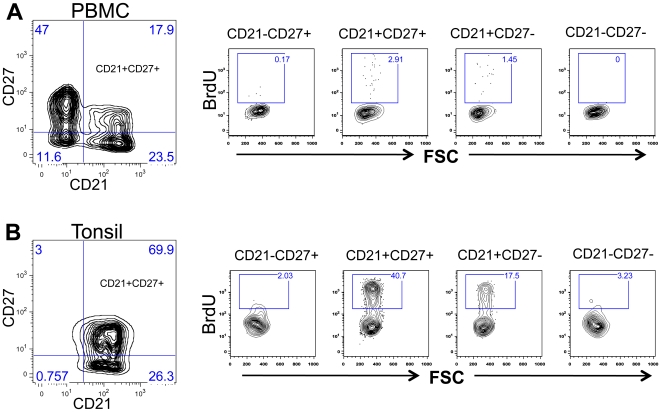
Representative flow cytograms show increased cell turnover (BrdU+) in DP CD21+CD27+ B cells in peripheral blood (A) and tonsillar (B) lymphocytes from a normal healthy uninfected rhesus macaque (GN74).Singlets were gated first to eliminate doublets and finally gating was performed on CD20+ B lymphocytes. All CD20+ B cells were further analyzed based on their CD21 and CD27 surface molecule expression. The percentage of BrdU+ cells is indicated in the top box of each panel. Note that DP CD21+CD27+ B cells had higher BrdU+ proliferating cells than other B cell subsets.